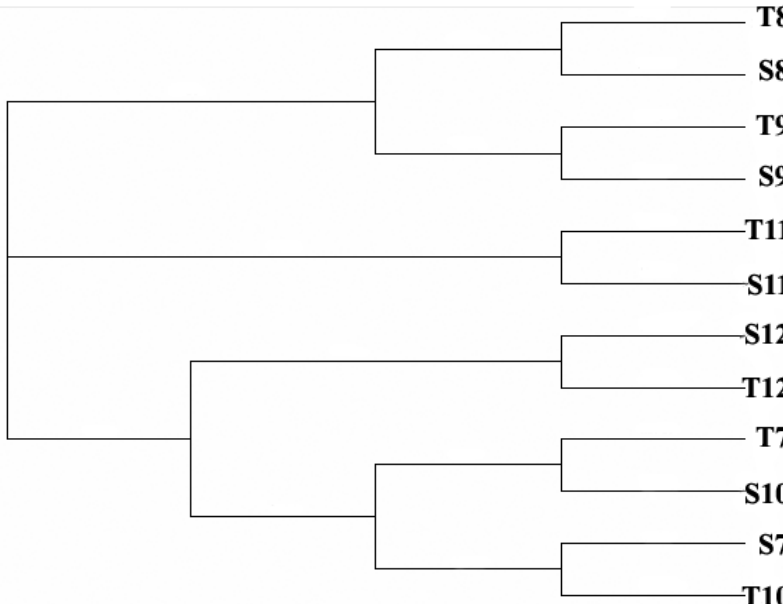
Figure 3. The cyanobacteria community structure system tree map of Tiegang and Shiyan reservoir water samples from July to December in 2007. T7–T12: Samples from July to December in Tiegang Reservoir; S7–S12: Samples from July to December in Shiyan Reservoir. The purpose of the tree is to show the